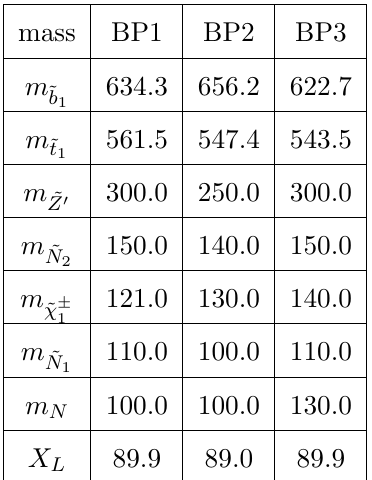
(cid:23) = 0 : 05 eV. e m